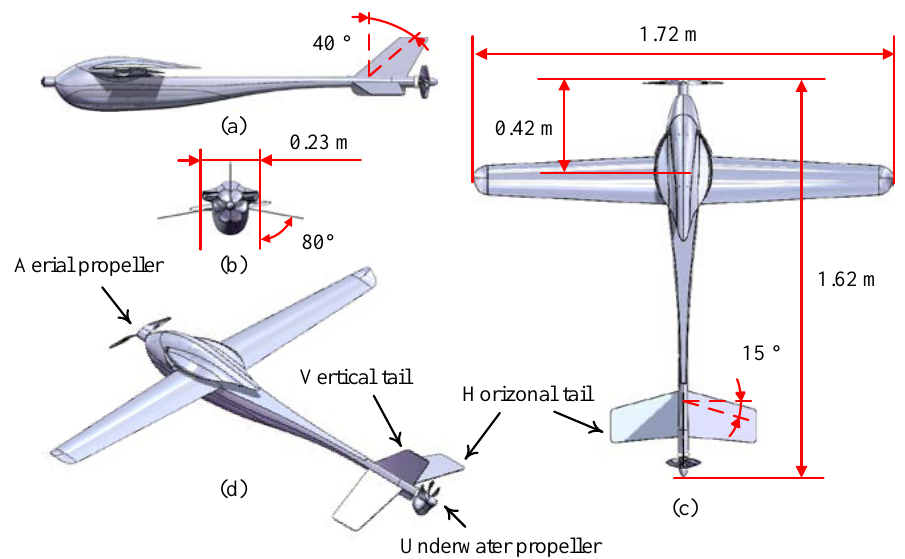
Figure 3. Prototype configuration for the UAUV: ( a – c ) three views; ( d ) stereogram view.